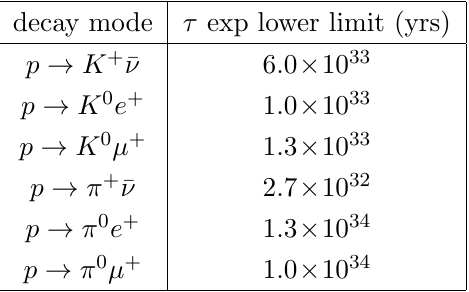
Table 7 . Experimentally determined lower limits [93] on the partial lifetimes of dominant proton decay modes considered in this